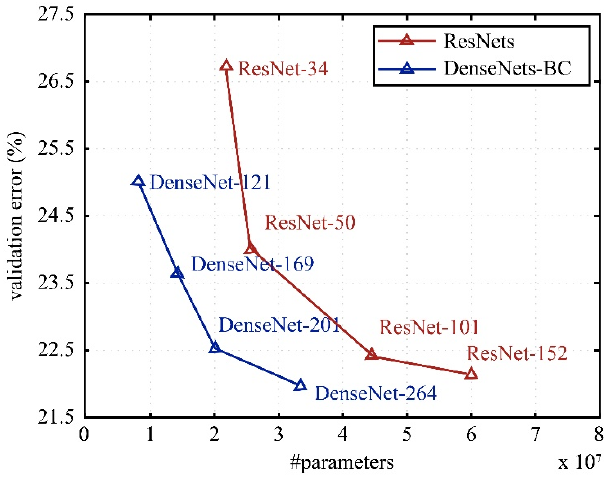
Figure 7. Comparison of the DenseNet and ResNet top-1 error rates (single-crop testing) on the ImageNet validation dataset as a function of the learned parameters (source: [19]).